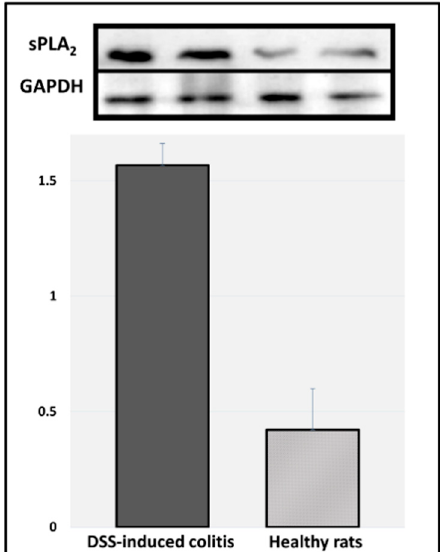
Figure 6. Western immunoblotting analysis of sPLA 2 expression (vs. GAPDH) in the colonic mucosa of DSS-induce colitis rats (2 left bands) vs. healthy animals (2 right bands), and their corresponding semi-quantitative analysis computerized using Image Studio Lite Ver. 5.2.